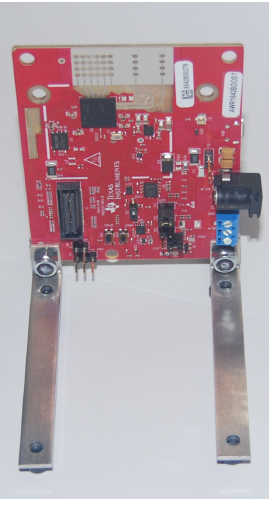
Figure 2. 77 GHz Texas Instruments automotive radar